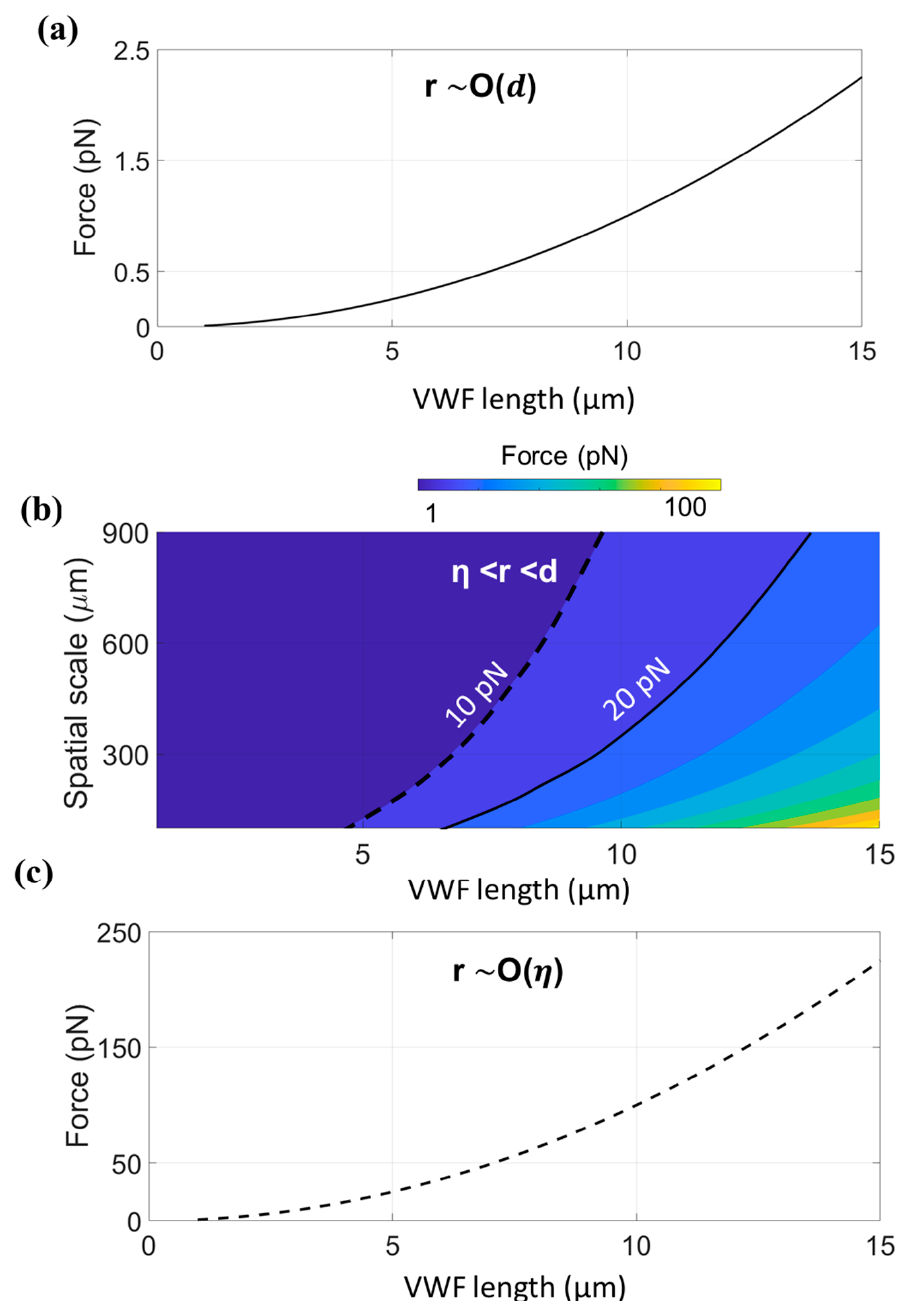
Figure 3. Force applied to VWF in the turbulent flow for different VWF contour length and spatial scale of ( a ) largest length scale r ∼ O( d ), ( b ) the inertial range ( η < r < d), the critical force for unfolding is in the range of 10–22 pN ( c ) the smallest length scale r ∼ O( η ).